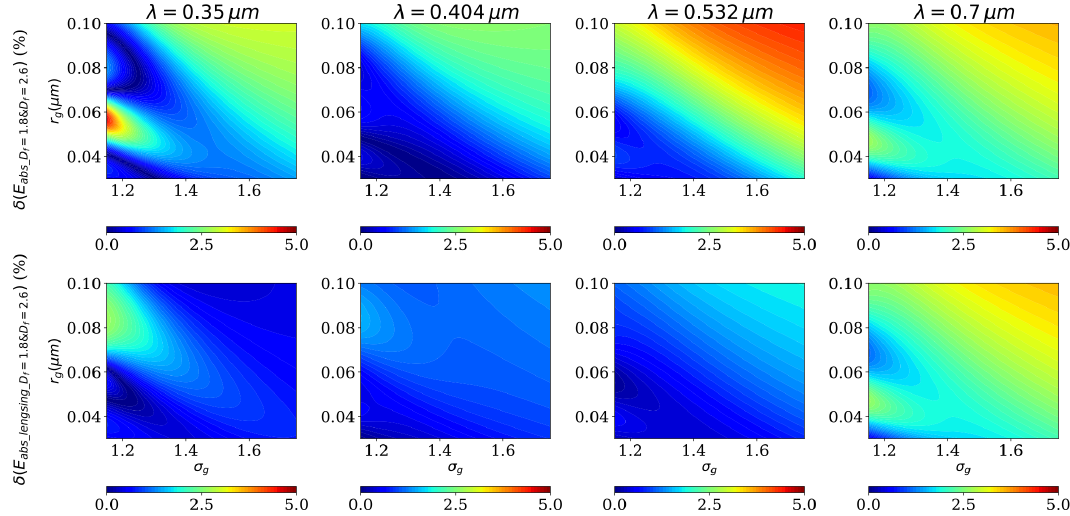
Figure 9. The relative deviations of absorption properties between D f = 1 . 8 and D f = 2 . 6 for thinly coated BC with BrC coating ( f BC = 20%).